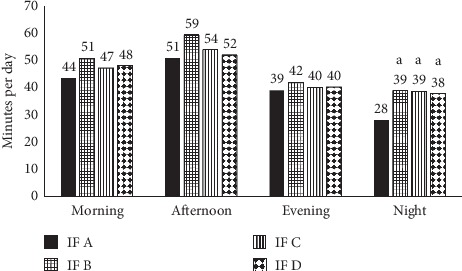
Crying/fussy behavior reported in subject diaries per IF. a denotes significant difference from IF A. IF A vs. IF Bp=0.004; IF A vs. IF Cp=0.026; IF A vs. IF Dp=0.002.